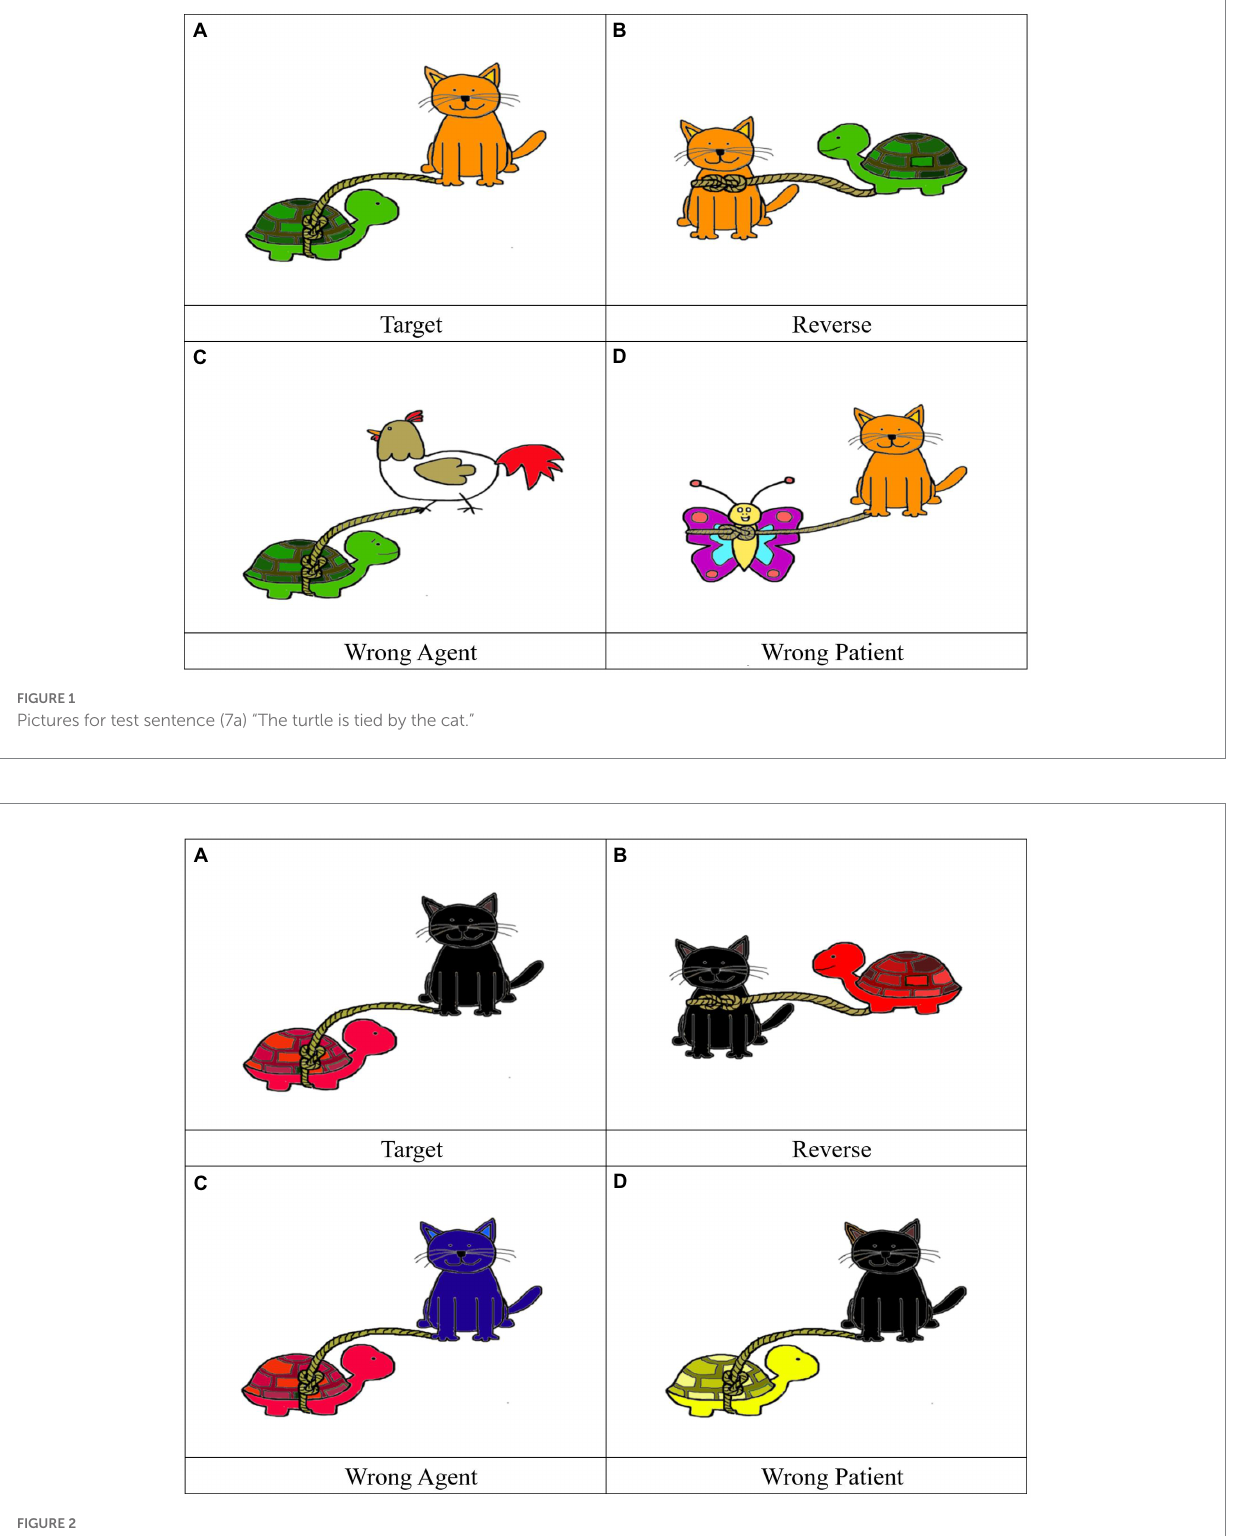
be examined in data analysis. Interspersed among the three blocks of target sentence types were trials of other sentence types such as relative clause and pivot construction.